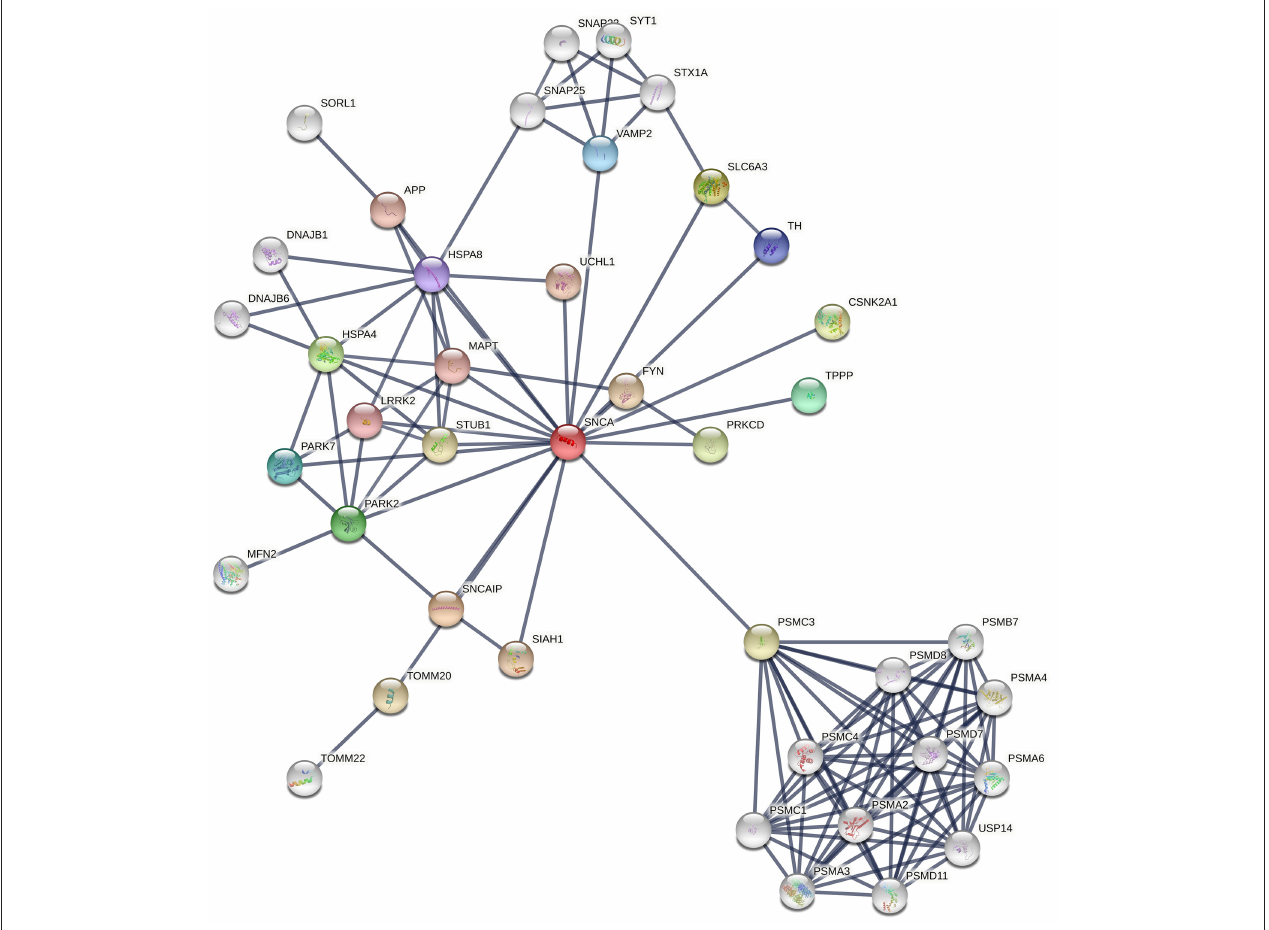
FIGURE 3 | Snapshot of interaction network of the different Proteins involved in PD pathogenesis from STRING Database. The thickness of lines indicates the confidence score for the interaction between two